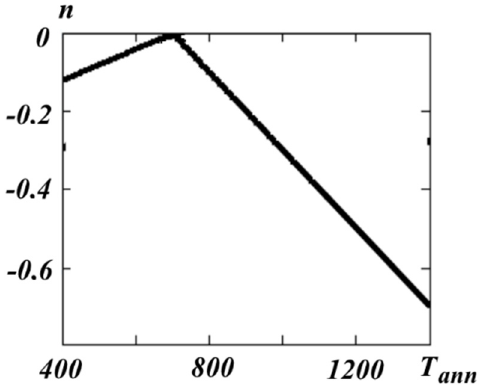
Figure 6. Dependence of exponent n on the annealing temperature T ann .